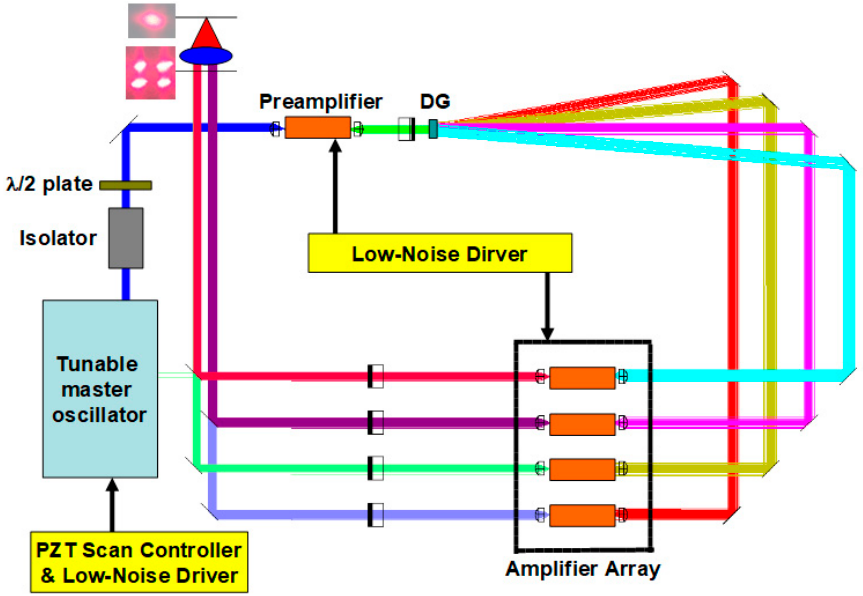
Figure 1. Configuration of the master oscillator power amplifier (MOPA) system. The inset shows the output and focused beam spots. DG: Dammann grating.